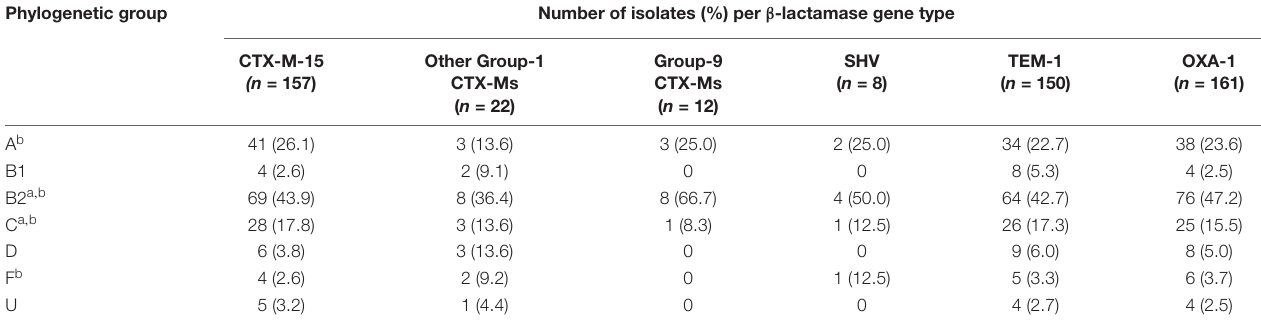
TABLE 3 | The phylogenetic distribution of ESBL producing E. coli isolated from clinical samples originating four health facilities in Ethiopia. Phylogenetic